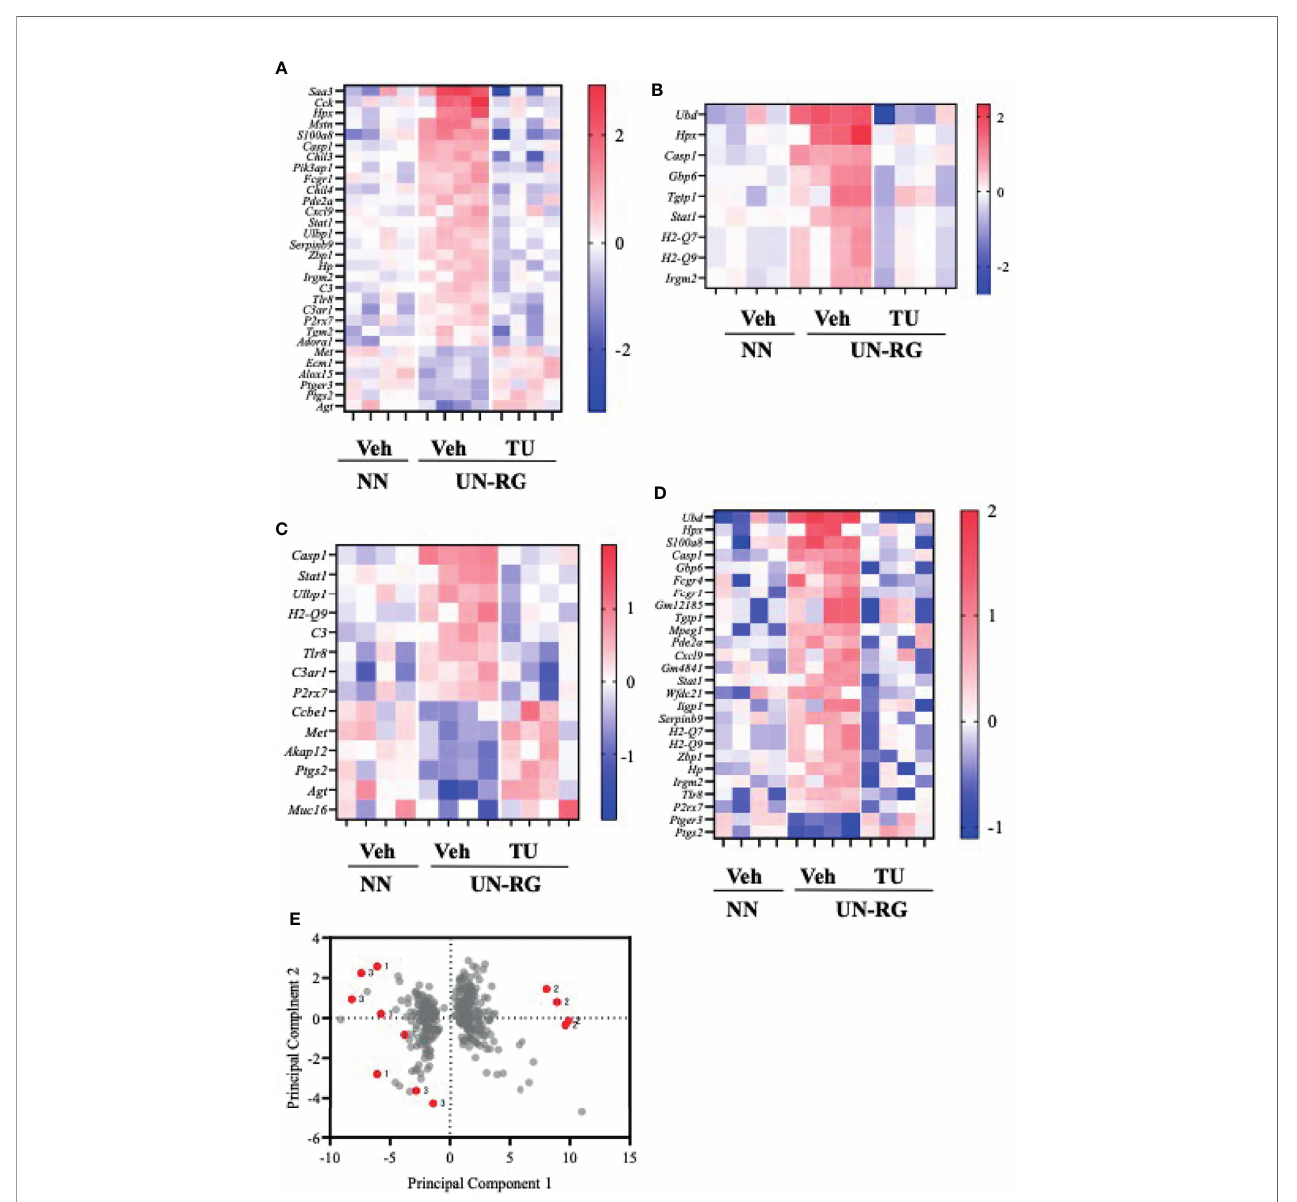
FIGURE 6 | Heatmaps of the mRNA expression of representative genes from 4 GO terms (A – D) and a principal component analysis (E) of NN-Veh, UN-RG-Veh, and UN-RG-TU pups (mean of 4 pups each). A ) In fl ammatory response, B ) Response to interferon- g , C ) Regulation of cytokine production, and D ) Cellular response to interferon- b . These 4 GO terms were commonly observed in two gene enrichment analyses, i.e. Figures 4B and 5B . (E) A principle component analysis: gray dots indicate principle scores, while red dots show the loading of NN-Veh (1), UN-RG-Veh (2), and UN-RG-TU (3). There was a tendency that NN-Veh (1) and UN- RG-TU (3) showed similar distribution in comparison with the distribution of UN-RG-Veh